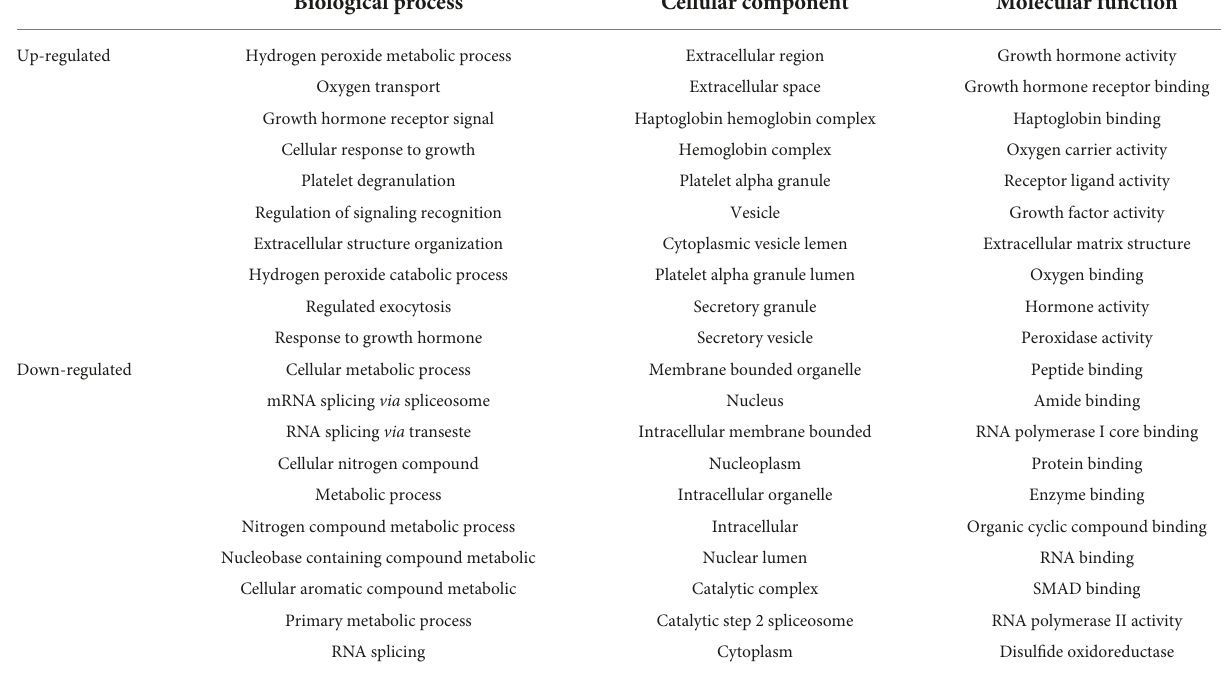
TABLE 2 Gene ontology (GO) analysis of differentially expressed genes (DEGs) in the plasma from child patients with congenital talipes equinovarus (CTEV) compared with normal children.